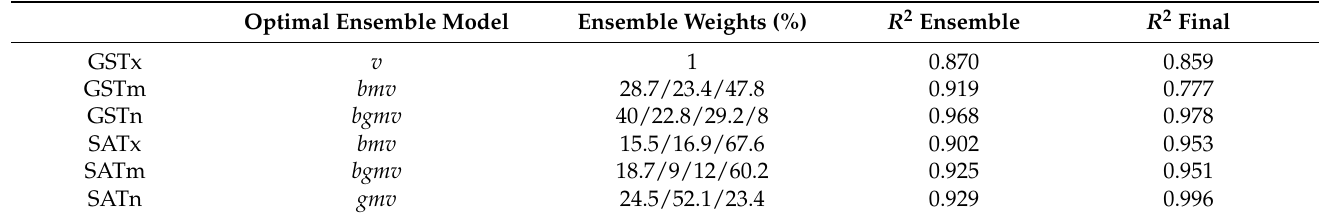
Table 2. The interpolation statistics of multiyear averaged GST- and SAT-related